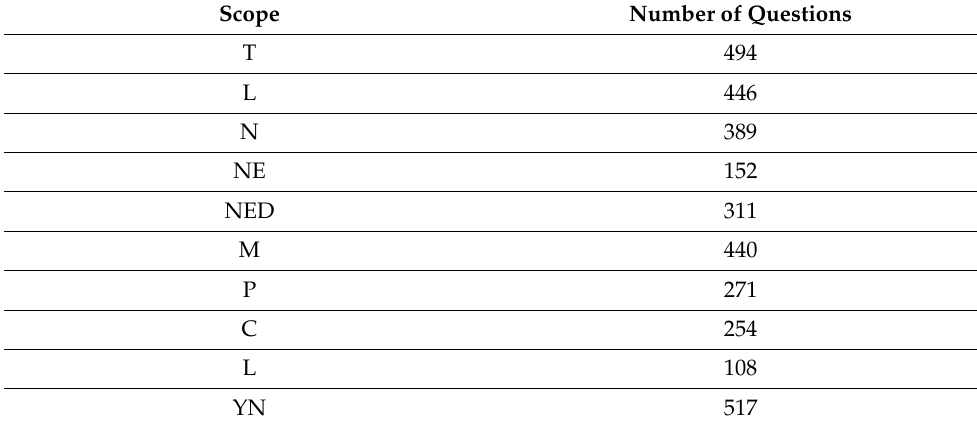
Table 2. The breakdown of the scopes of the 3382 unique